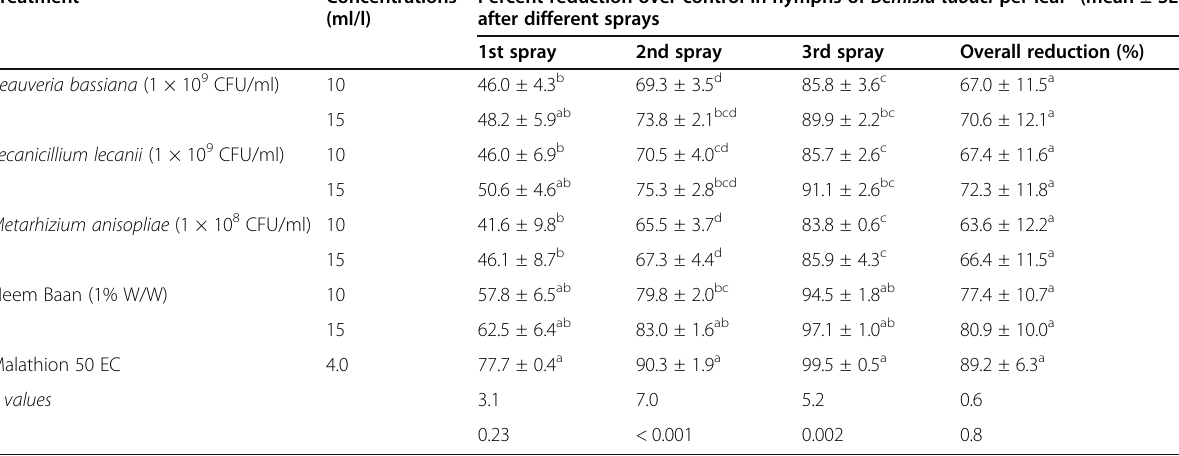
Table 5 Efficacy of different biopesticides against nymphs of Bemisia tabaci on cucumber under net house conditions during autumn cropping season (2018) Treatment